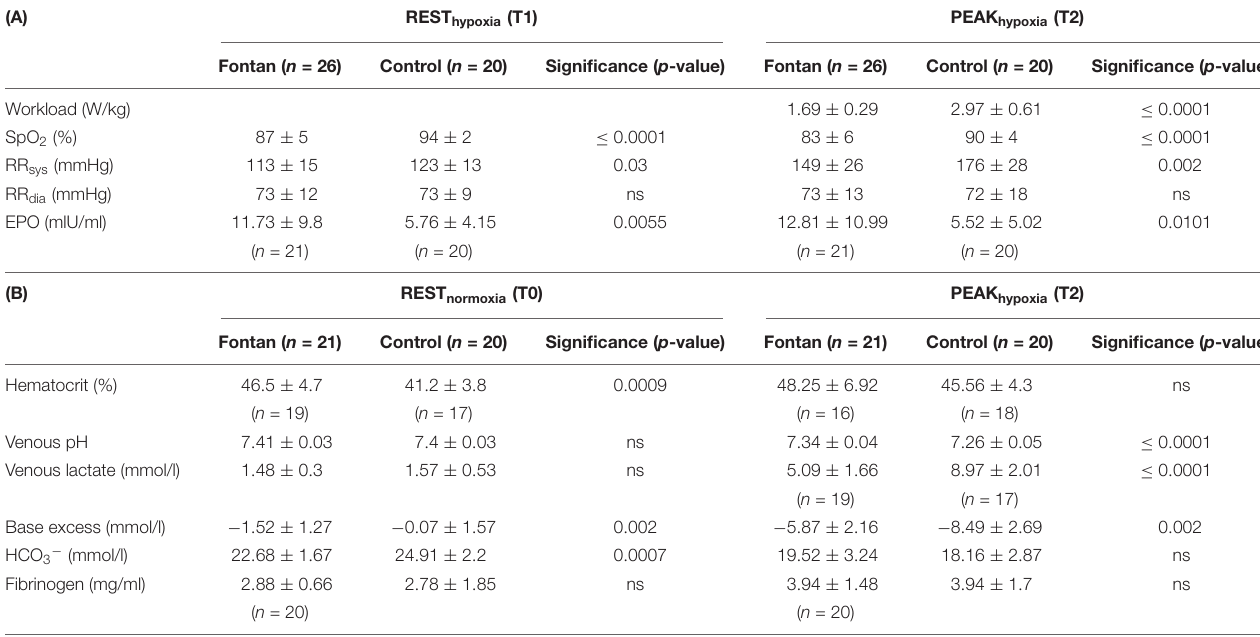
TABLE 2 | Results of (A) AET and (B) BGA and fibrinogen, n = number of values, ns = not significant.